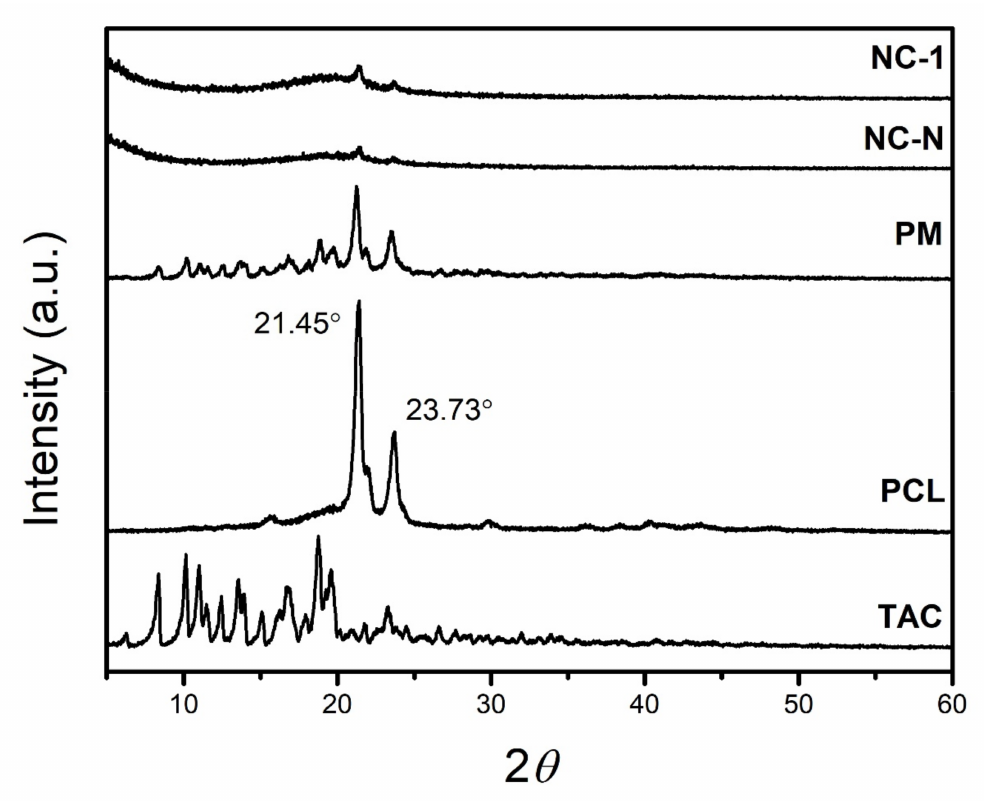
Figure 3. Difractograms of TAC, PCL, PM, and non-loaded (NC-N) and TAC-loaded (NC-1) nanocap- sules obtained by XRD